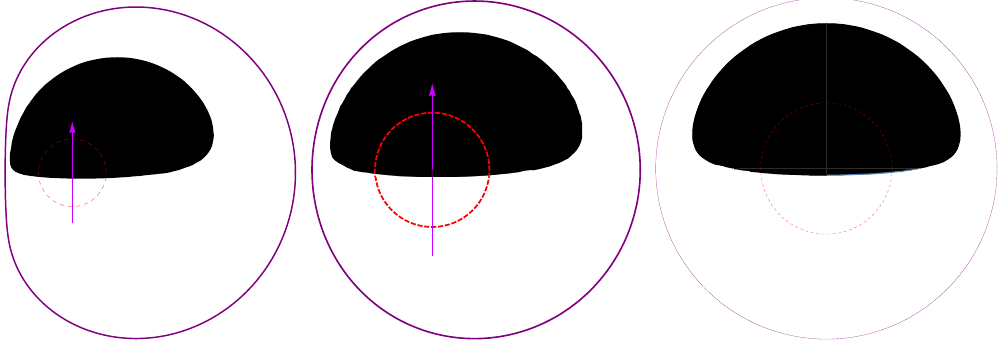
Figure 8. The dark silhouettes of the northern hemisphere of the event horizon (black region) in the case of supermassive black hole SgrA* ( θ 0 = 17 ◦ ), projected inside the boundary of classical black hole shadow (closed purple curves) for the values of black hole spin, respectively, a = 0.9982 ( left ), 0.65 ( middle ) and 0 ( right ).